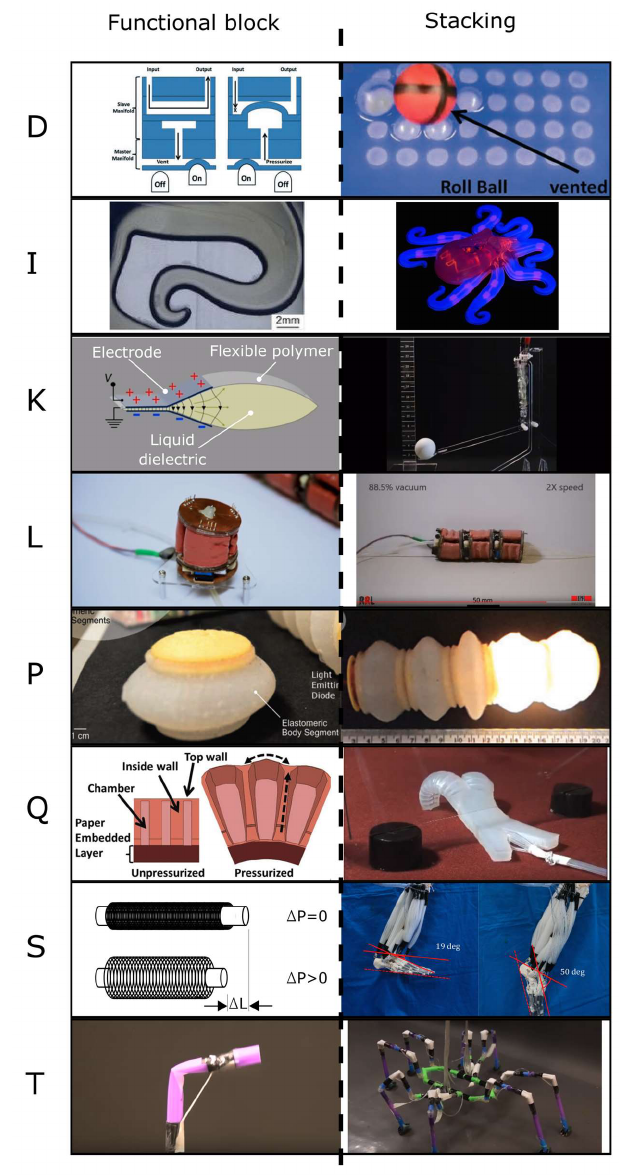
Figure 1. An example of functional blocks that are stacked to create systems that are greater than the sum of their parts. ( D ) A pneumatic Braille display. Reproduced from [38] with permission of The Royal Society of Chemistry; ( I ) the Octobot. Reprinted by permission from Springer Nature: Nature [15] (2016); ( K ) the Peano hydraulically amplified self-healing electrostatic actuator (HASEL) [39]; ( L ) the vacuum-powered soft pneumatic actuator (V-SPA) [31,32]; ( P ) the Wormbot. Wormbot [13] is licensed under CC BY 2.0 [40]; ( Q ) the multigait soft robot. Reproduced with permission from [3]; Copyright 2011 National Academy of Sciences; ( S ) McKibben actuators as a redundant musculoskeletal robot. Redundant musculoskeletal robot with thin McKibben muscles [41] is licensed under CC BY 4.0 [42]; ( T ) the Arthrobot